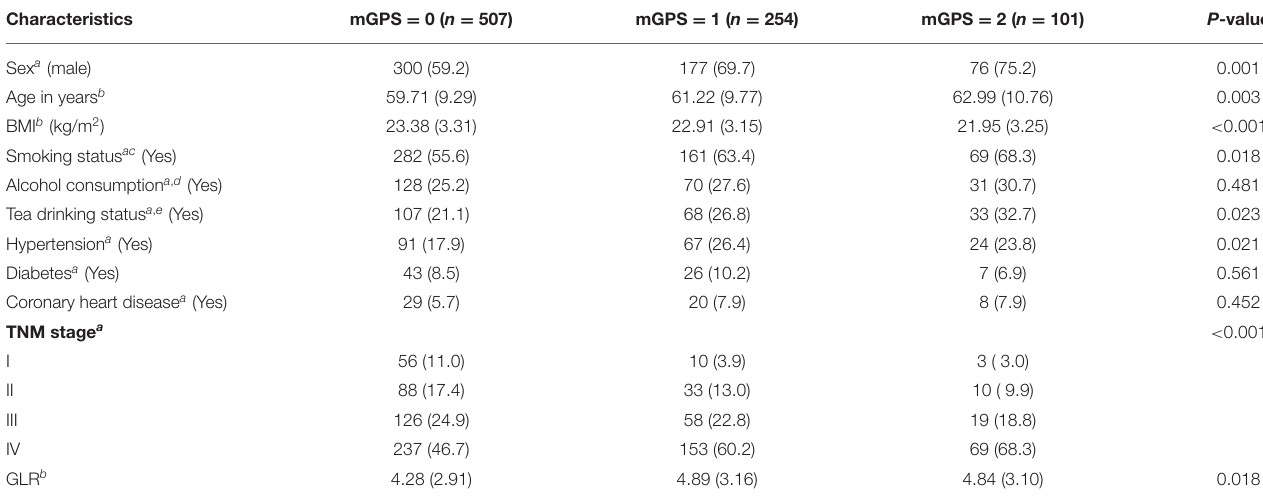
TABLE 1 | Characteristics of patients with different mGPS.